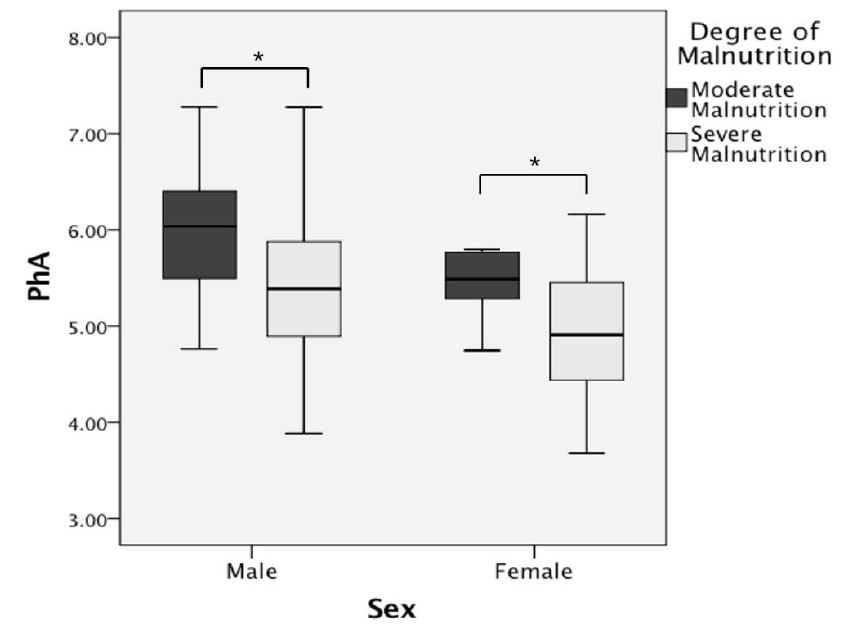
Figure 4. Box plot comparing PhA in CD patients with different degrees of malnutrition. Note: *: p <